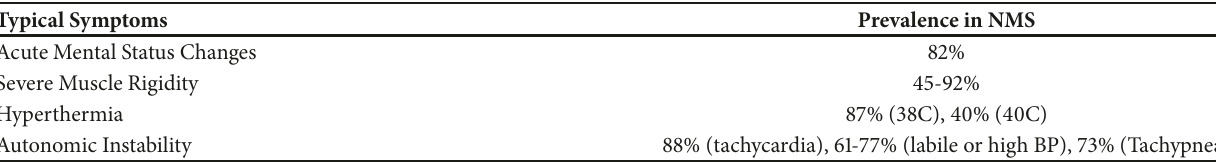
Table 1: Tetrad or cardinal features of NMS